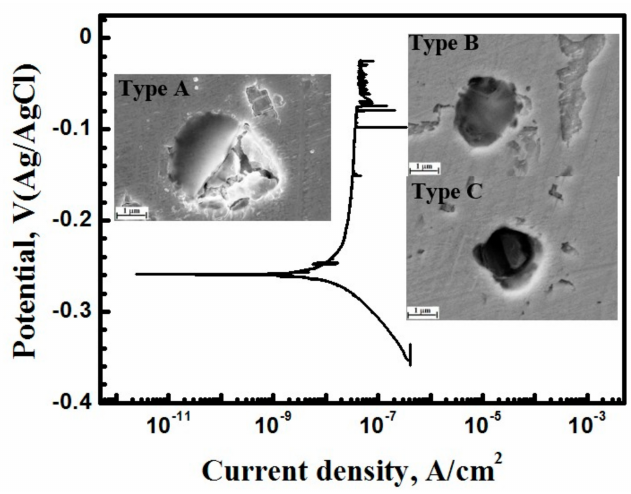
Figure 1. Slow scan rate potentiodynamic polarization curve and metastable pits morphology generated during the test in 0.5 mol/L NaHCO 3 + 0.1 mol/L NaCl solution.